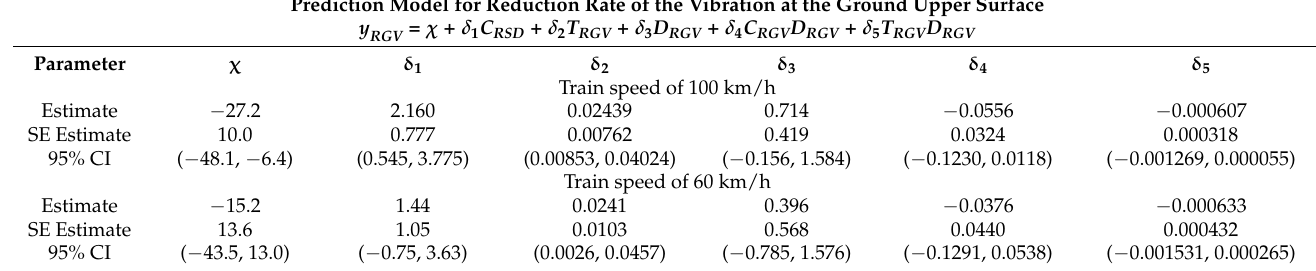
Table 10. Summary of prediction